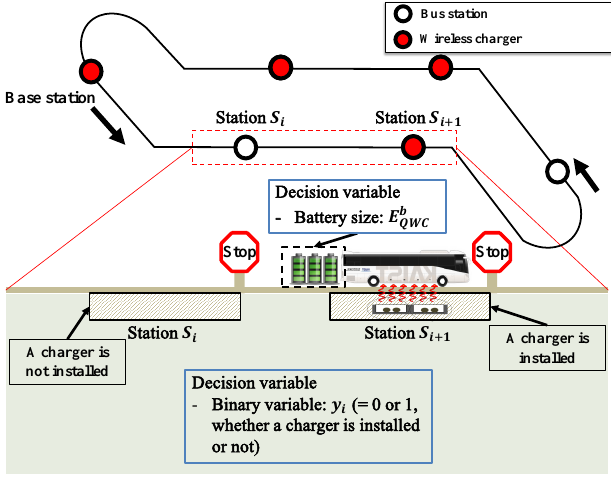
Figure 8. Decision variables for the system design of